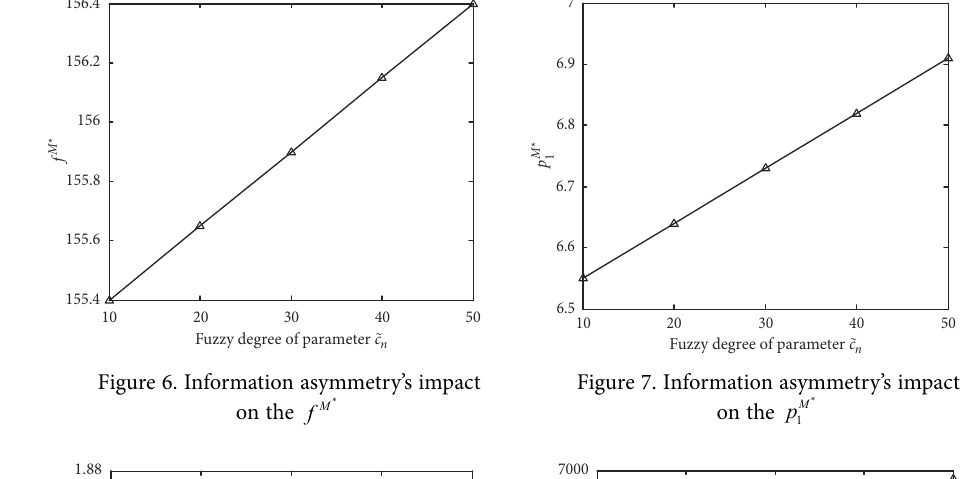
Figure 9. Information asymmetry’s impact on the